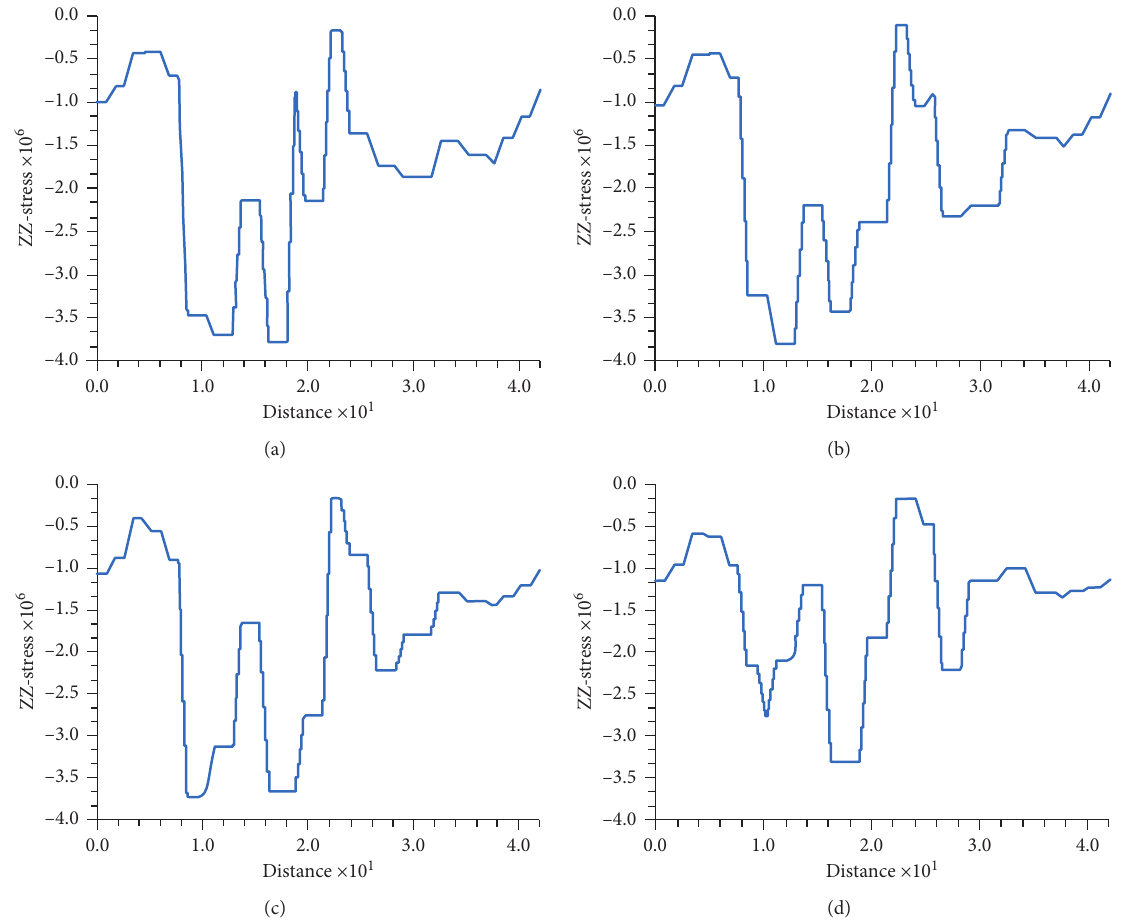
Figure 13: The stress distribution above the surrounding rock at different locations under improved support system. (a) Stress distribution above the tunnel 0m from (45 0 52.7) to (87 0 52.7). (b) Stress distribution above the tunnel 10m from (45 0 52.7) to (87 0 52.7). (c) Stress distribution above the tunnel 20m from (45 0 52.7) to (87 0 52.7). (d) Stress distribution above the tunnel 30m from (45 0 52.7) to (87 0 52.7).